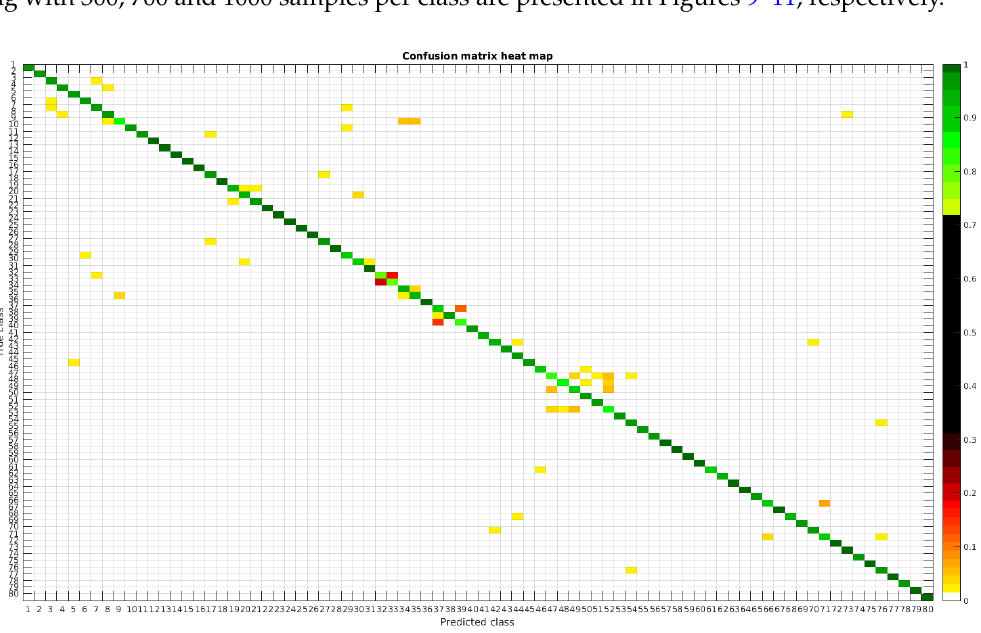
Figure 9. Confusion matrix heat map for the segmented dataset with 300 samples per class.